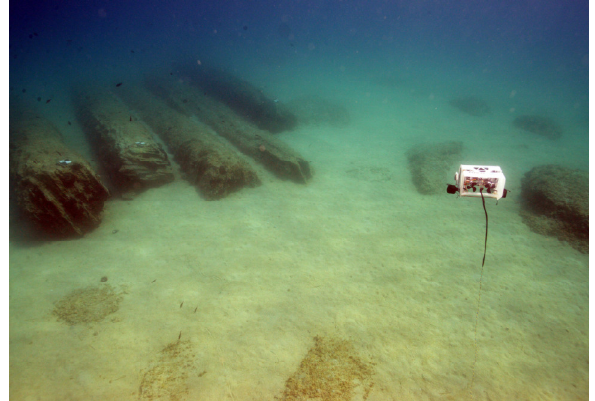
Figure 6. The imaging capture during the photogrammetric survey.